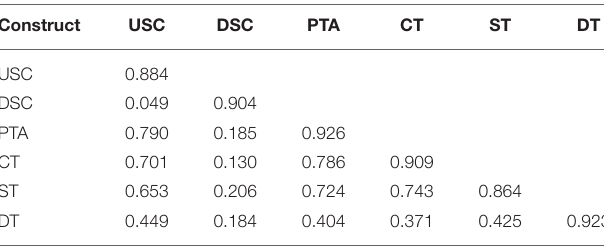
TABLE 3 | Construct discriminative validity